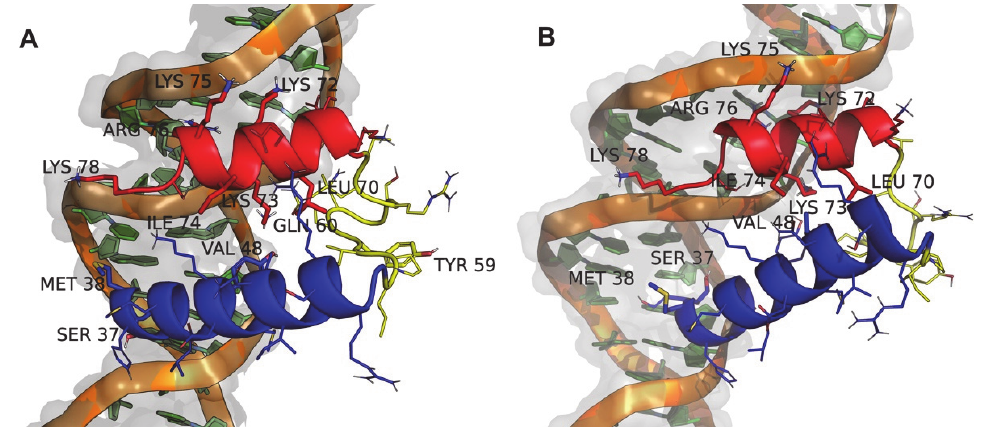
Figure 4. Representative structures of wt:p10/dsDNA from complex 2 ( A ) and 4 ( B ) systems. The wt:p10 protein is colored using the previously defined scheme (Figure 1). Residues from wt:p10 showing strong intramolecular and intermolecular interactions with dsDNA are represented as labeled thicker sticks.